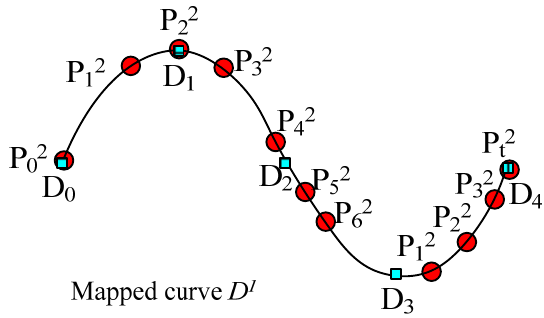
Figure 7. Arrangement of all key points in curve D 1 according to distance.